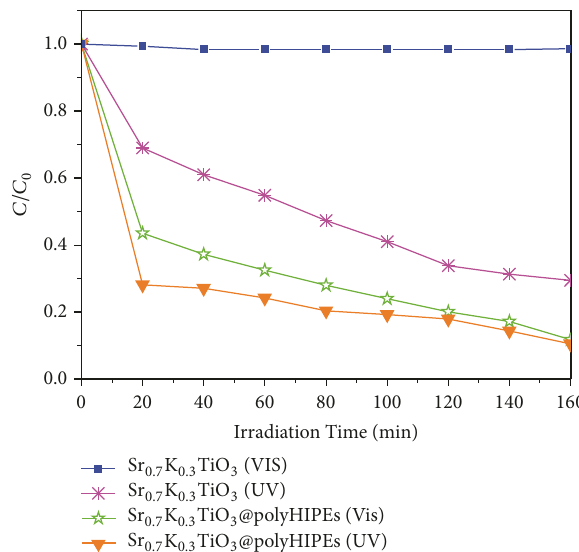
Figure 6: Photocatalytic decomposition of MB over Sr 1−𝑥 K 𝑥 TiO 3−𝛿 under UV (365 nm) irradiation. Figure 7: Photocatalytic properties over MB of Sr 0.7 K 0.3 TiO 3−𝛿 and Sr 0.7 K 0.3 TiO 3−𝛿 @PC-polyHIPEs under UV (365 nm) and Vis (450 nm) irradiation.